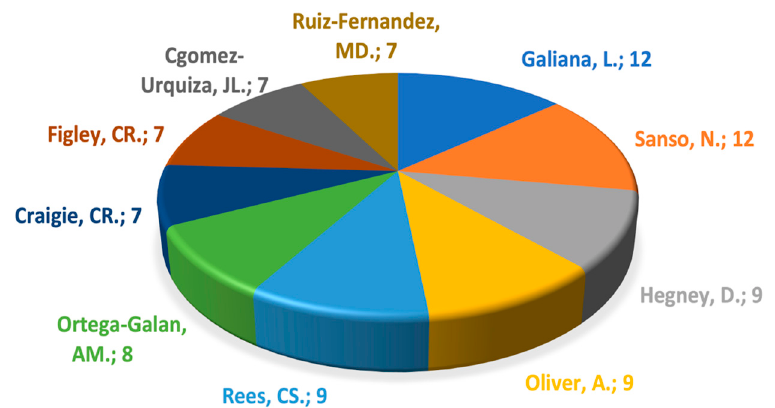
Figure 3. Top 3 countries with strongest citation bursts.